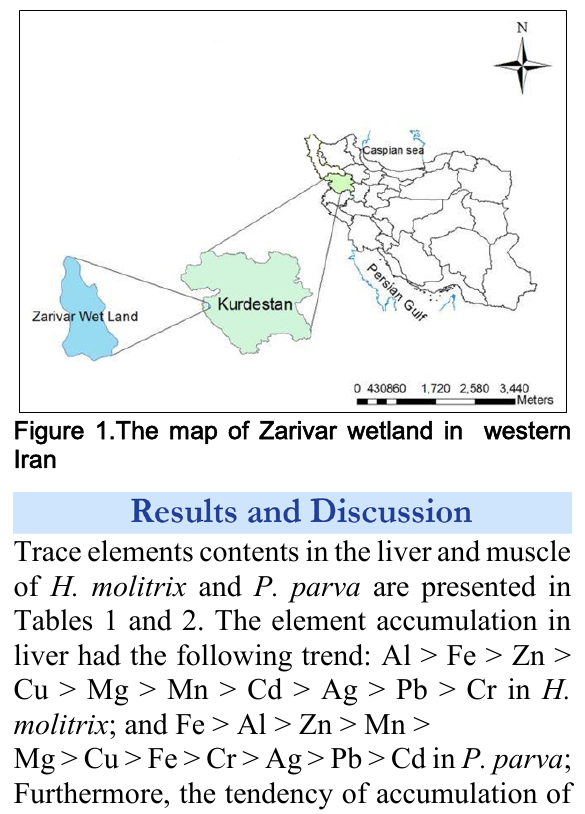
Table 1. Trace elements concentration (Mean and SD) in the liver of two fish in Zarivar wetland